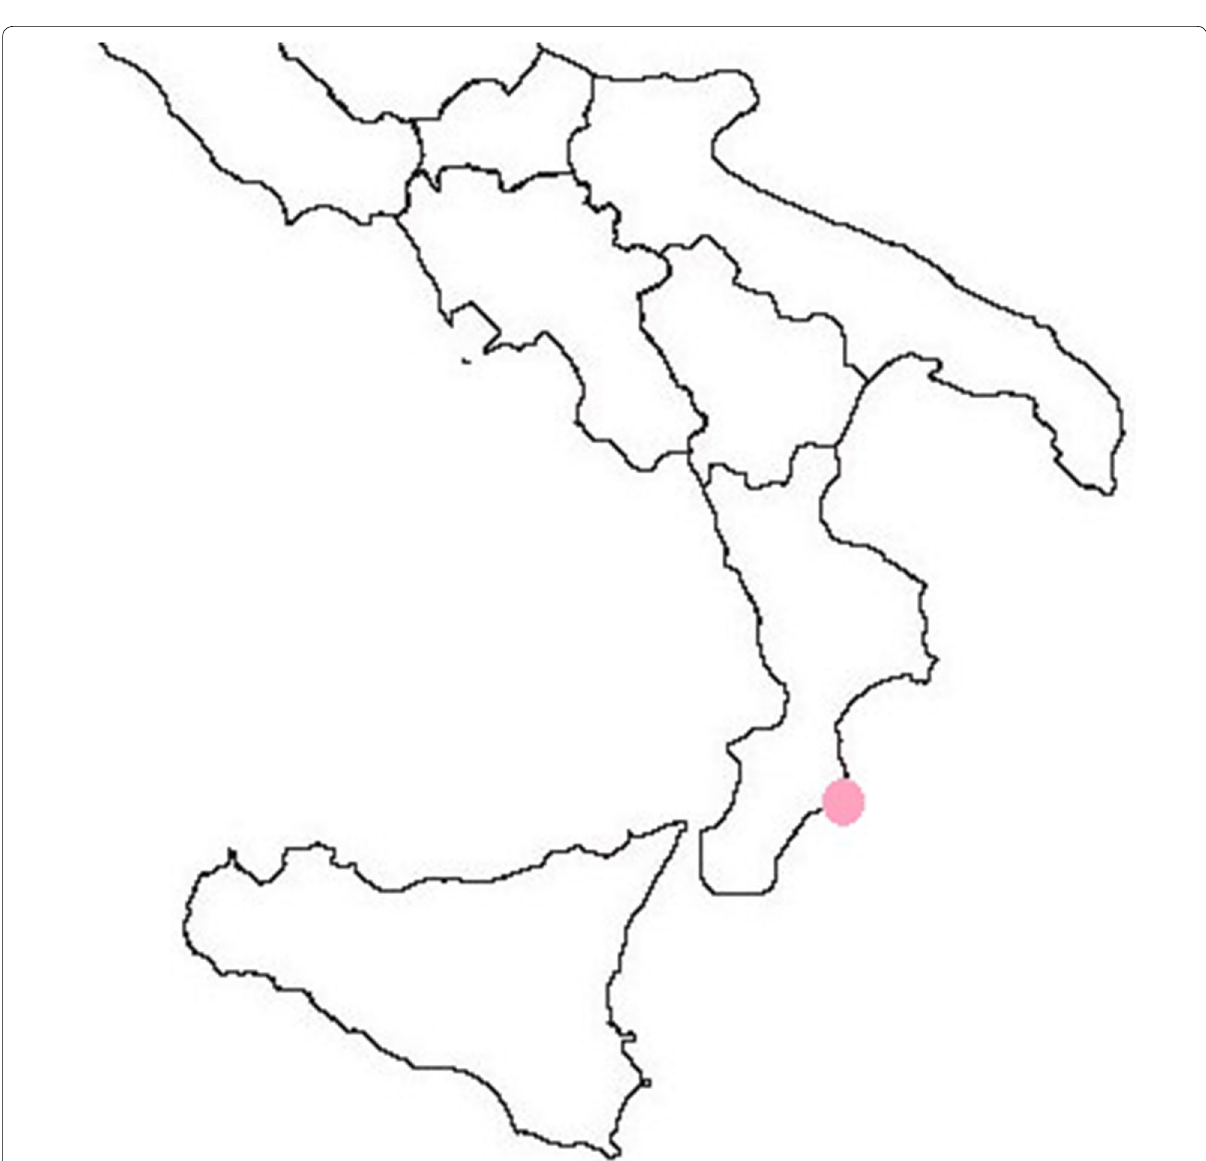
Fig. 1 Location of Riace in the broader context of